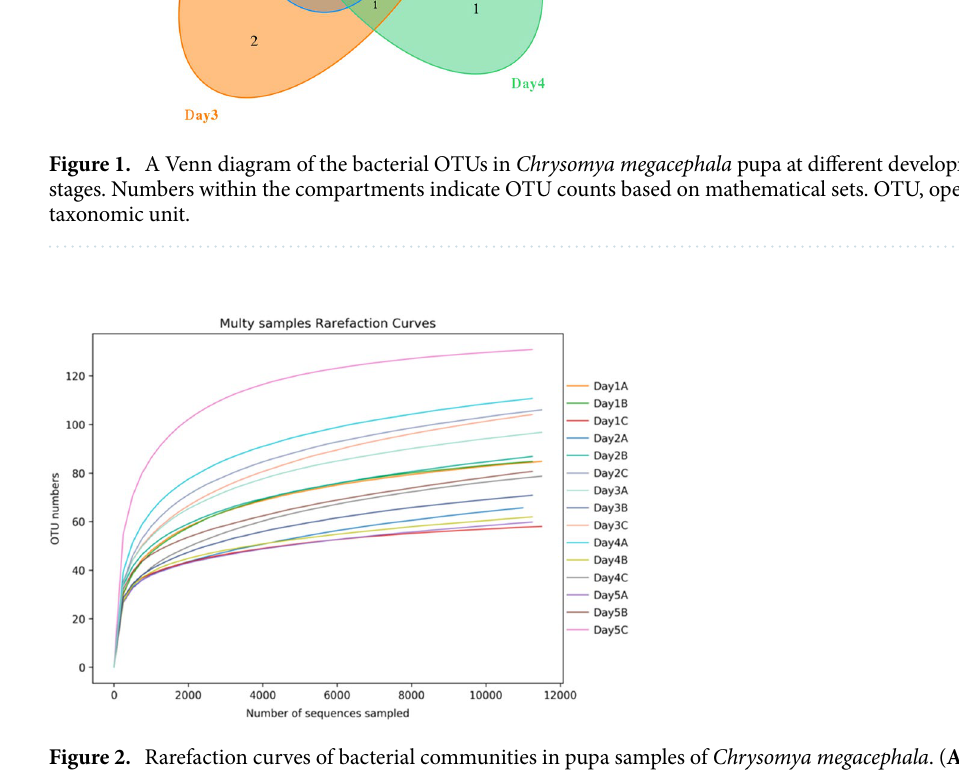
Figure 2. Rarefaction curves of bacterial communities in pupa samples of Chrysomya megacephala . ( A – C ) The different biological